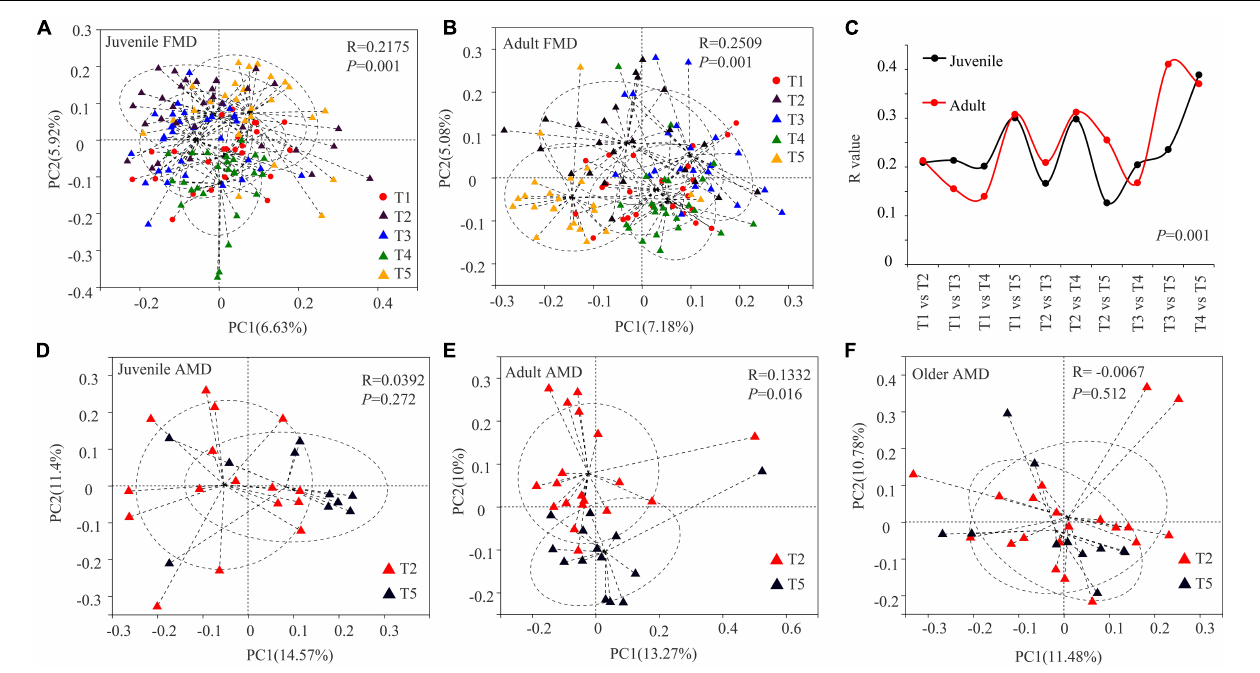
FIGURE 2 | PCoA analysis of gut microbial composition of musk deer in different seasons. Principal coordinate plot between five different periods in juvenile FMD (A) and adult FMD (B) . (C) ANOSIM analysis of gut microbiota between every two seasons in FMD ( Supplementary Figures 2 , 3 ). PCoA analysis between late spring and winter groups in juveniles (D) , adults (E) , and older (F)